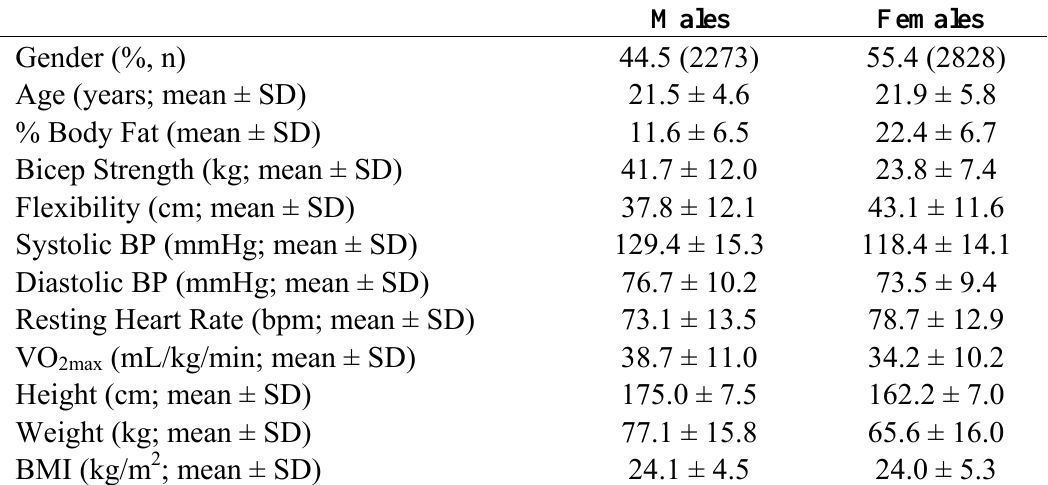
Table 1. Characteristics of the study